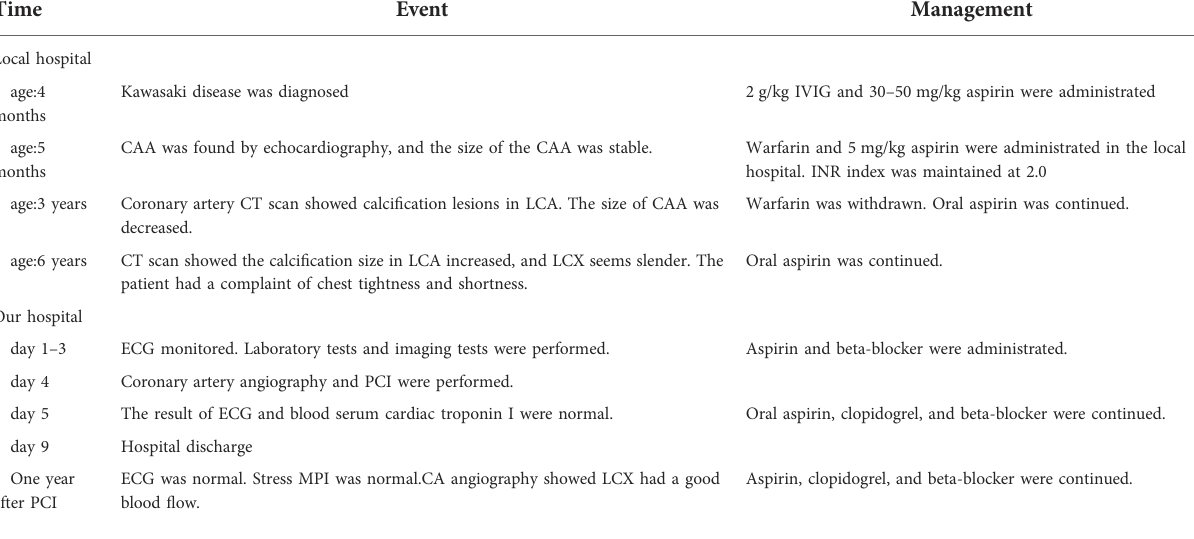
TABLE 1 Timeline of diagnosis and therapy of the patient.